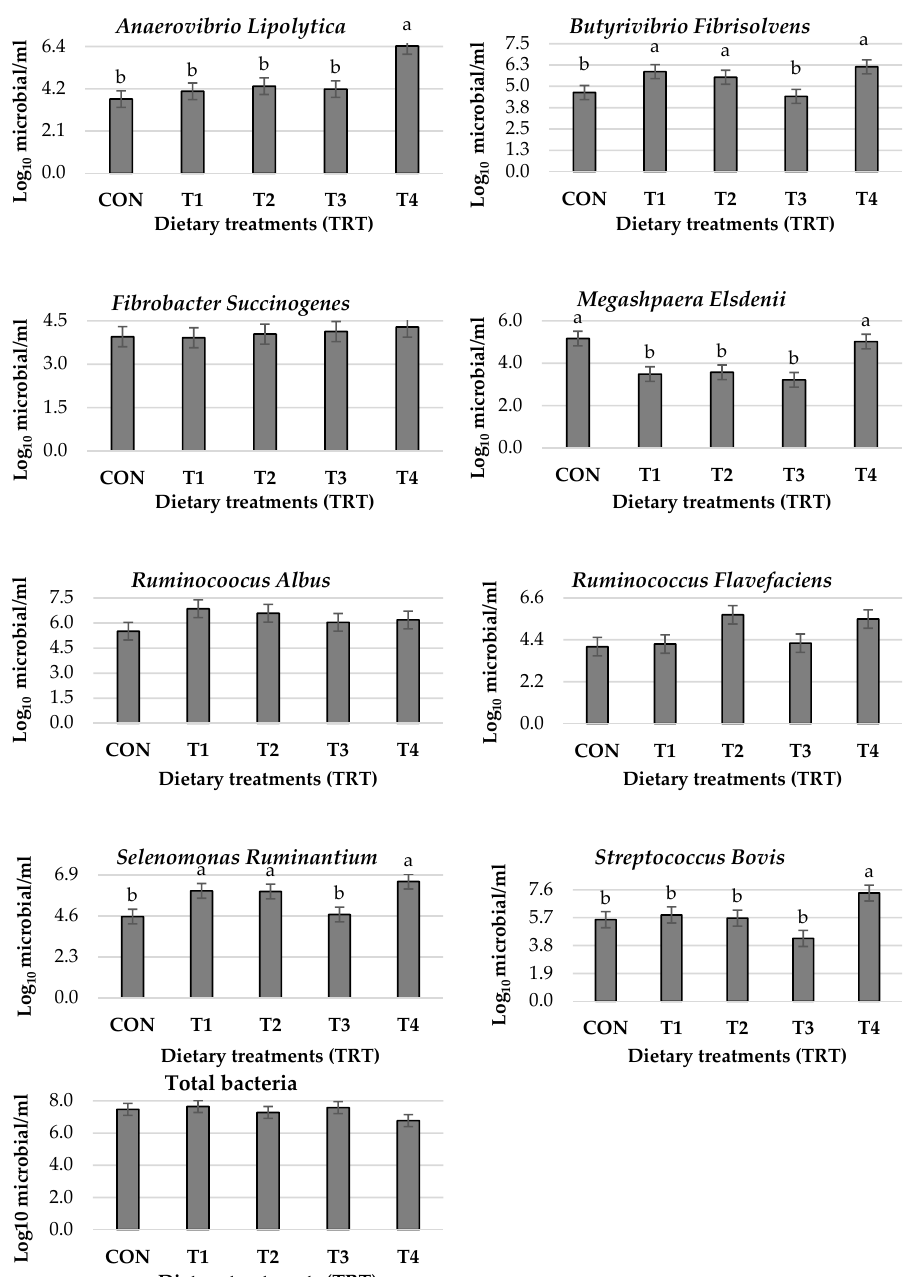
Figure 1. Effect of dietary treatments on ruminal bacterial quantification of growing lambs. Dietary treatments, CON = traditional diet 100% (barley 70%: alfalfa hay 30%); T1 = traditional diet 75%: sprouted barley 25%; T2 = traditional diet 50%: sprouted barley 50%; T3 = traditional diet 25%: sprouted barley 75% and T4 = sprouted barley 100%. a,b Means values within rows for each item with clarification of the significant difference in the form of superscripts ( p < 0.05). Anaerovibrio Lipolytica ( p -value: TRT = 0.002; L = 0.035; Q = 0.067). Butyrivibrio Fibrisolvens ( p -value: TRT = 0.029; L = 0.080; Q = 0.908). Fibrobacter Succinogenes ( p -value: TRT = 0.943; L = 0.718; Q = 0.782). Megashpaera Elsdenii ( p -value: TRT = 0.001; L = 0.002; Q ≤ 0.0001). Ruminocoocus Albus ( p -value: TRT = 0.452; L = 0.141; Q = 0.187). Ruminococcus Flavefaciens ( p -value: TRT = 0.057; L = 0.128; Q = 0.707). Selenomonas Ruminantium ( p -value: TRT = 0.010; L = 0.015; Q = 0.819). Streptococcus Bovis ( p -value: The effects of dietary treatments on lamb rumen histomorphometry are shown in TRT = 0.015; L = 0.701; Q = 0.082). Total bacteria ( p -value: TRT = 0.5003; L = 0.720; Q = Table 6. The papilla height, papilla width, and SA of papillae increased in lambs that received dietary treatments (T2 and T3) and decreased when lambs received 100% sprouted barley (T4) compared with CON ( p < 0.05). Replacing the traditional diet with 75% sprouted barley (T3) had the lowest papilla density compared with T1 and T4 but was not affected compared with T2 and CON ( p < 0.05). Therefore, TSP was greater in sprouted barley (T1 to T3) than in T4 and CON ( p < 0.05). Lambs fed 100% sprouted barley (T4) had a higher SC than the other dietary treatments ( p < 0.05). The WE was higher at T2, followed by T1, T3, and T4 compared to CON ( p < 0.05). Dietary treatment of T3 increased the LP and SM more than CON ( p < 0.05). In addition, all histomorphometric measurements showed a quadratic response ( p < 0.05), except for papilla density and stratum corneum, which were neither linearly nor quadratically affected by the dietary treatments ( p > 0.05). An example of a representative rumen histomorphometric from each dietary treatment is shown in Figure 2. Table 6. Effect of dietary treatments on the rumen histomorphometric of growing lambs. Dietary Treatments (TRT) 2